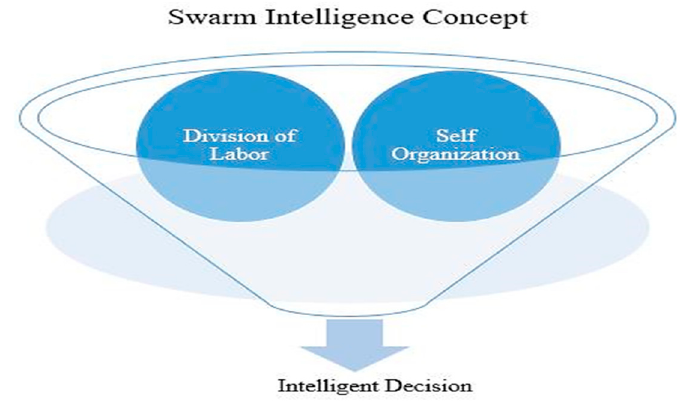
Figure 2. Swarm intelligence Concept.